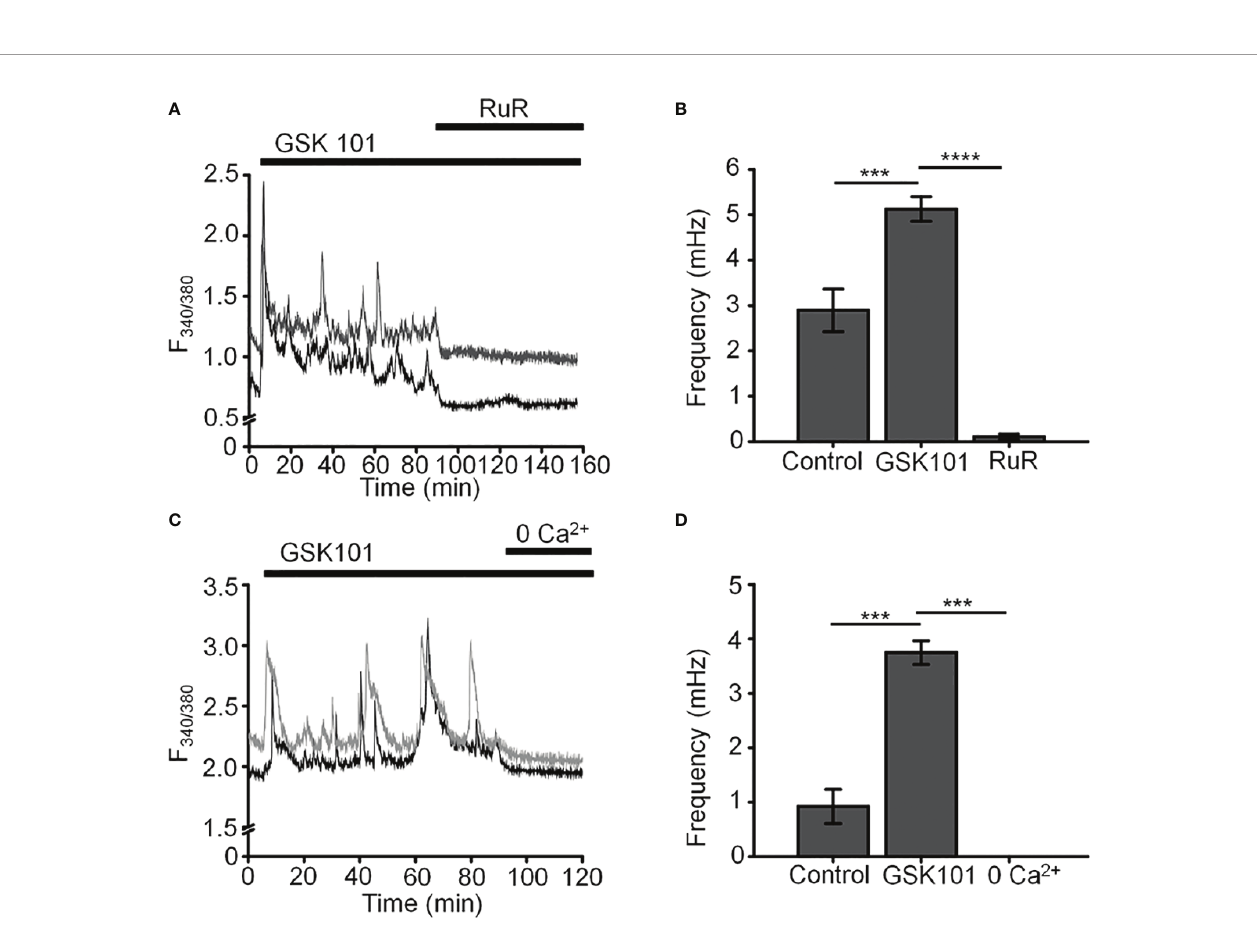
FIGURE 2 | GSK101-induced [Ca 2+ ] i oscillations requires activity of Ca 2+ -permeable and Ca 2+ -dependent TRP channels. Shown are representative traces. (A, C) GSK101-induced [Ca 2+ ] i fl uctuations are abolished by the nonselective TRP blocker Ruthenium Red (RuR; 10 µM) and in the absence of free extracellular Ca 2+ . (B, D) RuR and Ca 2+ -free solution abolish GSK101 induced [Ca 2+ ] i oscillations. Mean ± S.E.M. ***P < 0.001, ****P < 0.0001, paired t-test, n = 51 and n = 43 cells for (B, D) ,